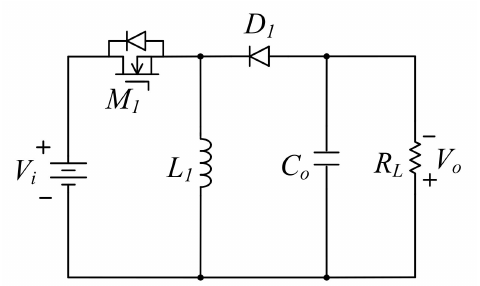
Figure 2. Schematic diagram of buck-boost converter for battery charging applications.